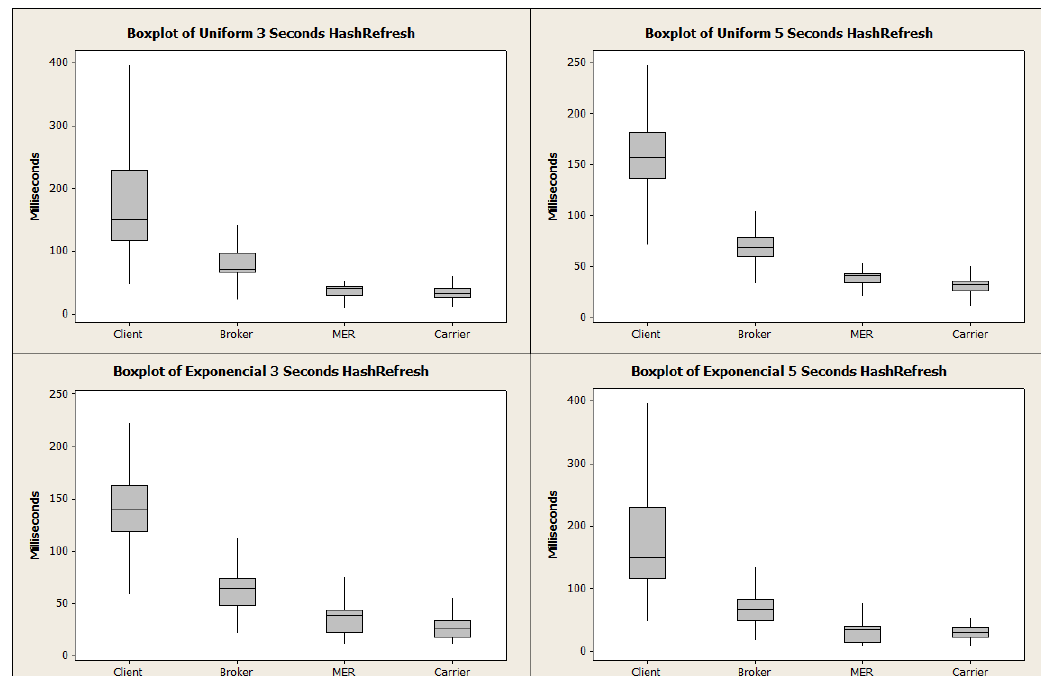
Figure 8. Average of HashRefresh time